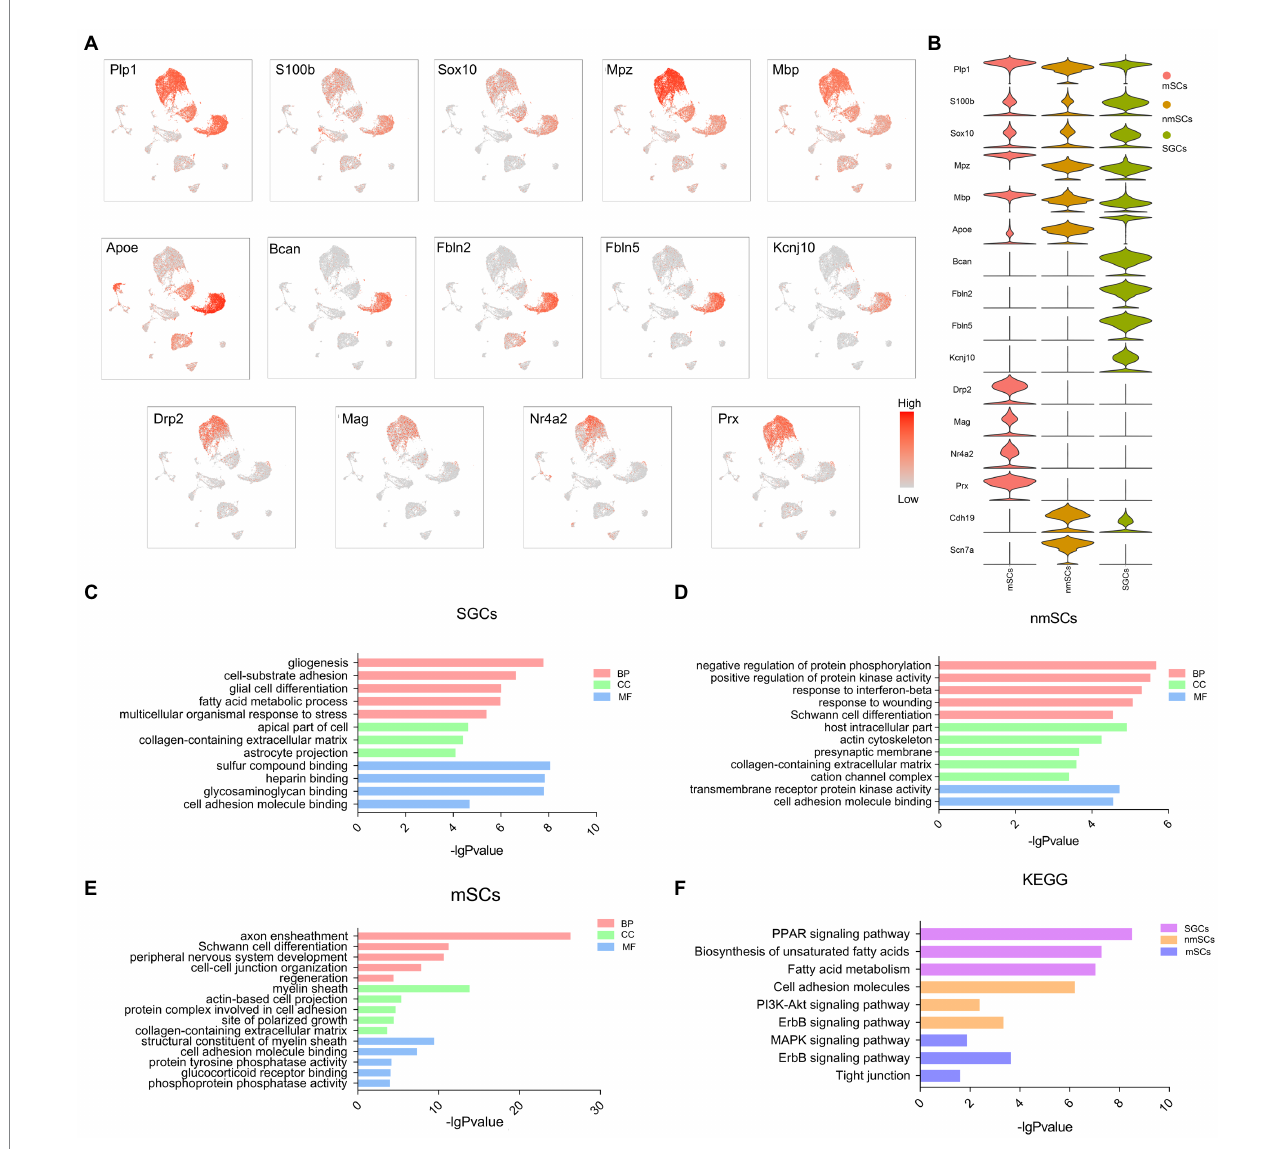
FIGURE 3 The signature gene expression in three peripheral glial cells of TG and the corresponding functional enrichment. (A) The UMAP plots of selected signature genes for SGCs, mScs and nmSCs. (B) The violin plot showing the distribution of glial cell signature genes in figure (A) in SGCs, mScs and nmSCs. (C–E) Gene ontology enrichment analysis of the biological process (BP), cellular component (CC), and molecular function (MF) for SGCs, mSCs, nmSCs. (F) KEGG analysis for the highly expressed genes of SGCs, mSCs, and